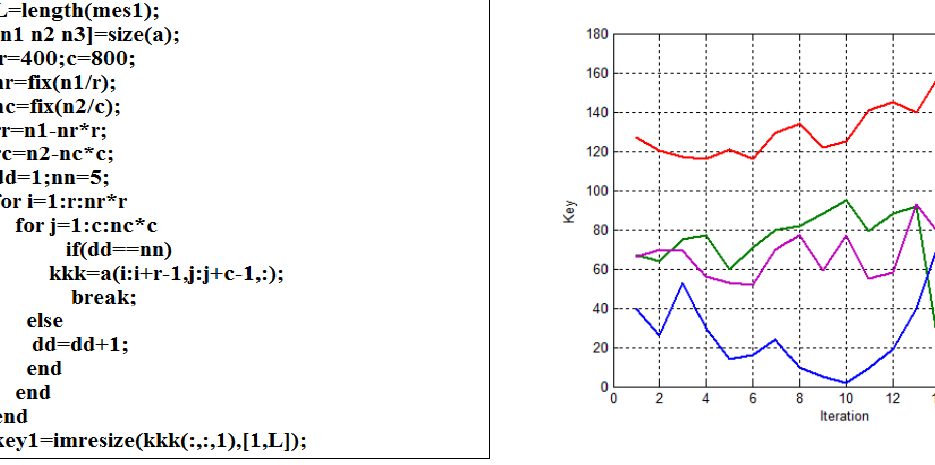
Fig. 5 . Sequence of operations to get IPK Fig. 6 . Sensitivity of